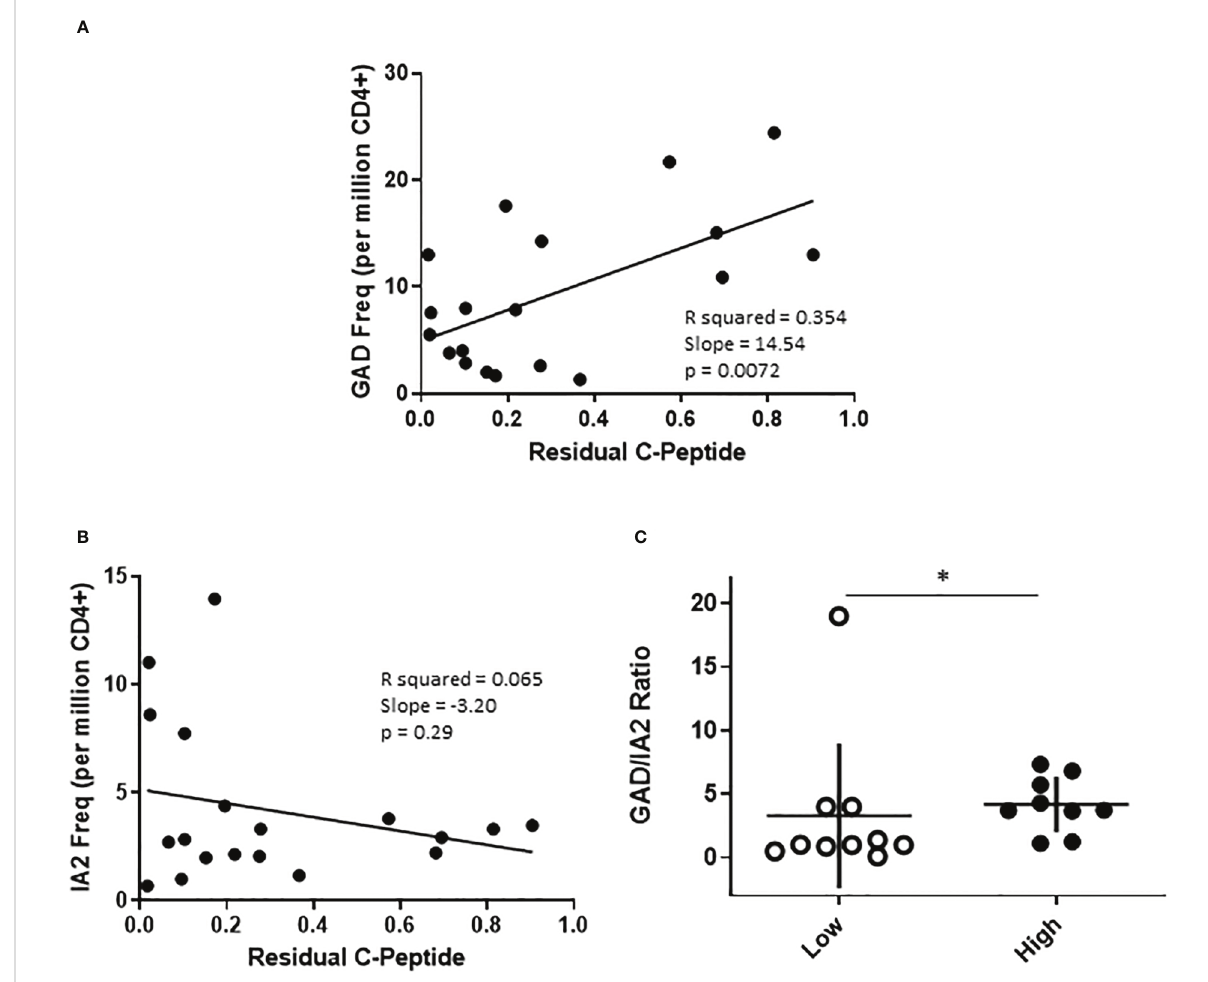
FIGURE 4 The pro fi les of PTM speci fi c T cells are distinct in subjects with high or low residual c-peptide. The subjects with T1D in our study were recruited to have diverse levels of residual c-peptide. (A) Examining PTM GAD speci fi c T cells revealed a linear relationship between the frequency of PTM GAD-speci fi c T cells and the level of residual c-peptide (p=0.0072, simple regression). (B) However, there was not a signi fi cant linear correlation between the frequency of PTM IA-2-speci fi c T cells and the level of residual c-peptide (p=0.29, simple regression). (C) Grouping subjects based on low (<0.2 mm/L, n=10 open circles) or high (>0.2 mm/L, n=9 fi lled circles) residual c-peptide revealed that the low group had a signi fi cantly lower proportion of PTM GAD-speci fi c T cells (expressed as GAD/IA2 frequency ratio) than the high group (p=0.05, Mann Whitney test). Horizontal lines indicate the mean value for each group. Vertical lines indicate standard